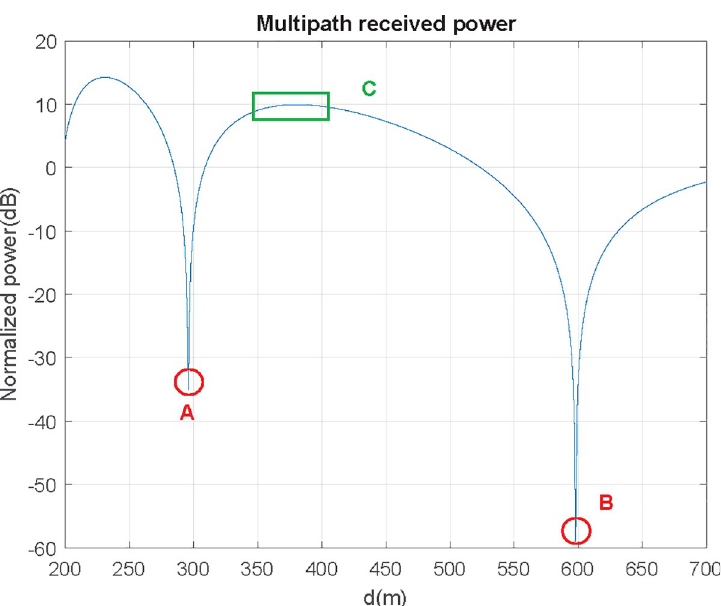
Fig 8. Avoidable and recommended measurement zones due to multipath effect (f = 900 MHz, h AUT = 2 m, h UAV = 50